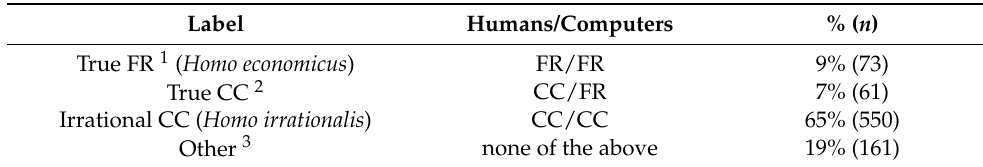
Table 2. Homo irrationalis . Behavioral types according to classification when grouped with Humans and when grouped with Computers.